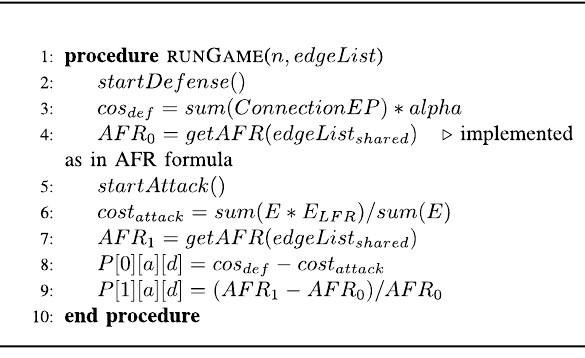
Figure 2. Pseudocode for Initialize Offense